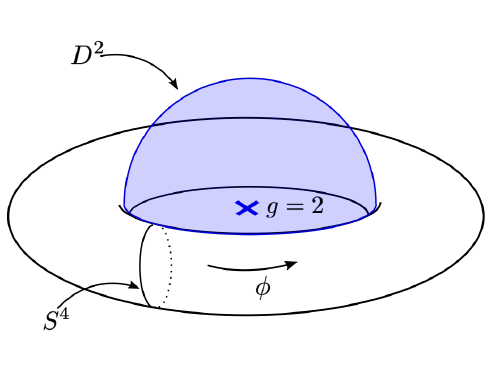
Figure 1: Schematic illustration of the extension of the mapping torus S 4 × S 1 to the 6- manifold S 4 × D 2 , made possible by embedding SU ( 2 ) as a subgroup of U ( 2 )